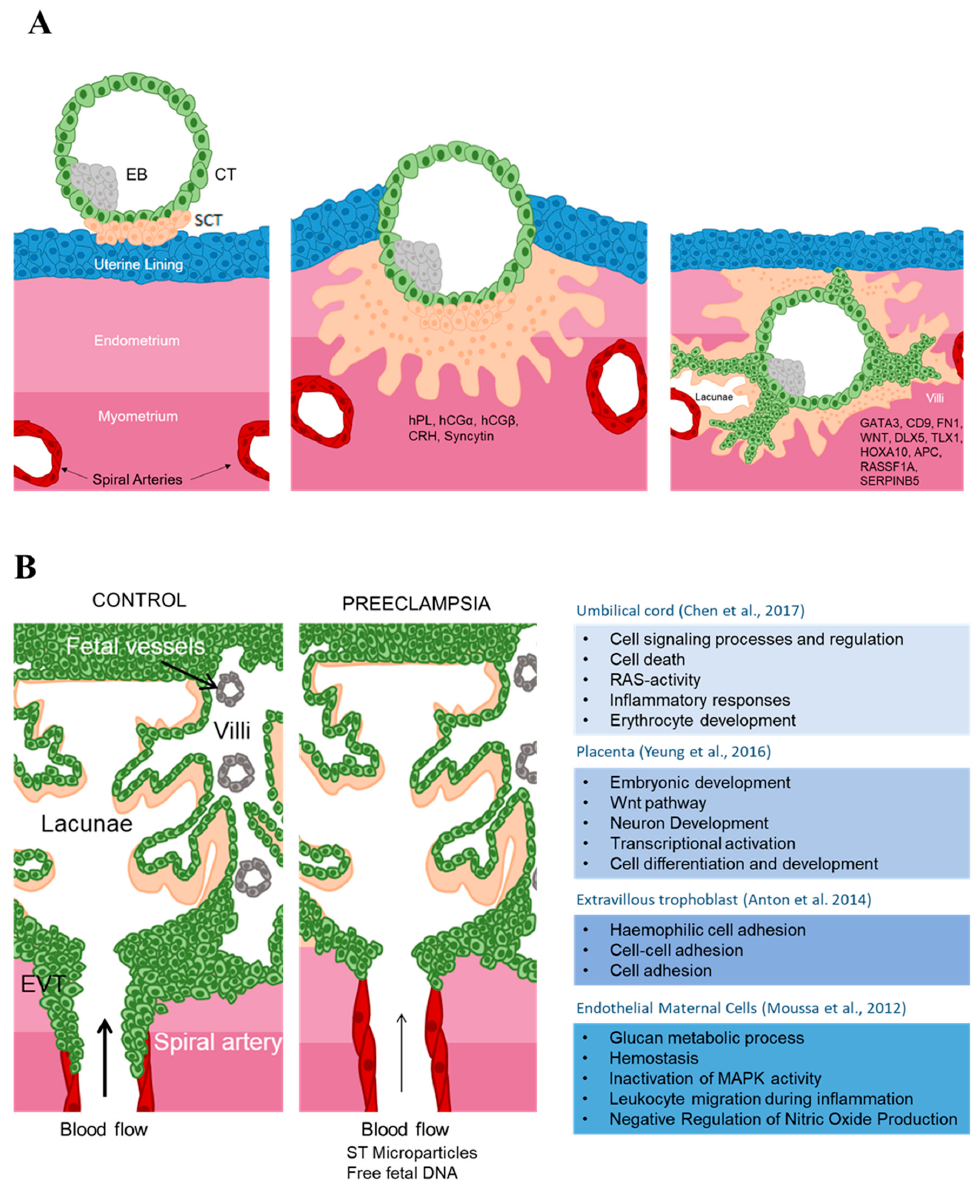
Figure 1. ( A ) Blastocyst implantation and Placenta Development: After recognizing the uterine lining, the blastocyst is formed by the embryoblast (EB) and the cytotrophoblast (CT). The cytotrophoblast starts to differentiate into Synctiotrophoblast (SCT). SCT invades the endometrium towards the maternal spiral arteries located in the myometrium. deregulation of numerous genes is observed [19]. Lacunae develop in the syncytiotrophoblast, which will eventually constitute the intervillous space. Genes upregulated during villi formation are presented on the right figure [20]. Other cytotrophoblasts will invade the maternal spiral arteries by differentiating into Extravillous trophoblast. ( B ) Gene Ontology of genes differentially methylated in PE compared to control samples: ( Left ) in normal pregnancies, extravillous trophoblast (EVT) invades the maternal spiral arteries allowing for an increased blood stream towards the extravillous space. Nutrients cross the placenta, are directed towards the embryonic vessels and collected in the umbilical cord. In PE, decreased invasion of the EVTs induces poor spiral artery remodeling, leading to poor blood flow towards the placenta. Increased amount of microparticles from the syncytiotrophoblast and increased amount of free fetal DNA is observed in the maternal blood. ( Right ) Gene ontology of differentially methylated genes found in PE samples in different tissues affected during pregnancy: Umbilical cord, placenta, EVT, Endothelial Maternal cells (see text for